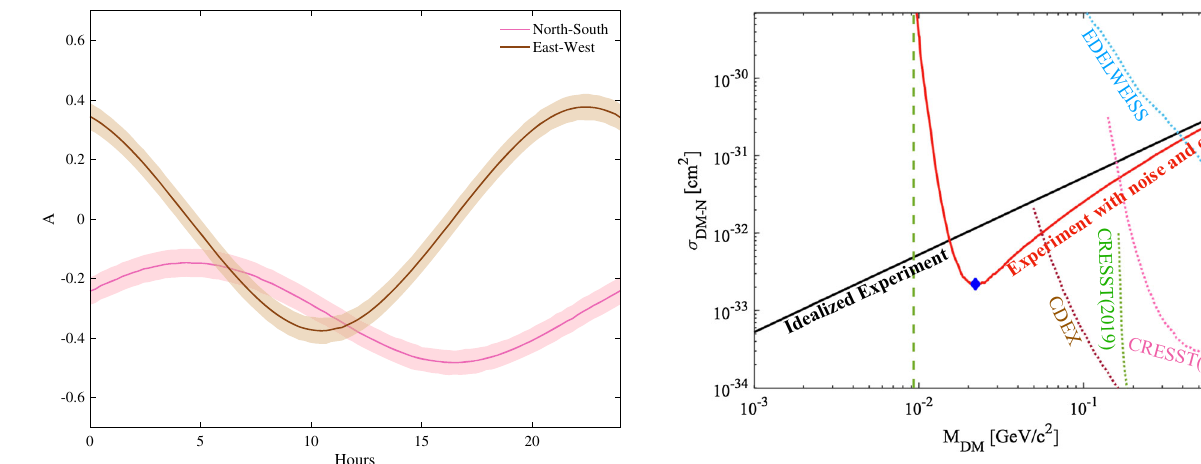
Fig. 1 The expected time dependence of the asymmetry A in north- south (pink) and east-west direction (brown) in the earth frame within 24 h in Hsinchu on June 1st. The colored bands represent the estimated 1 σ uncertainty. For more details see main text